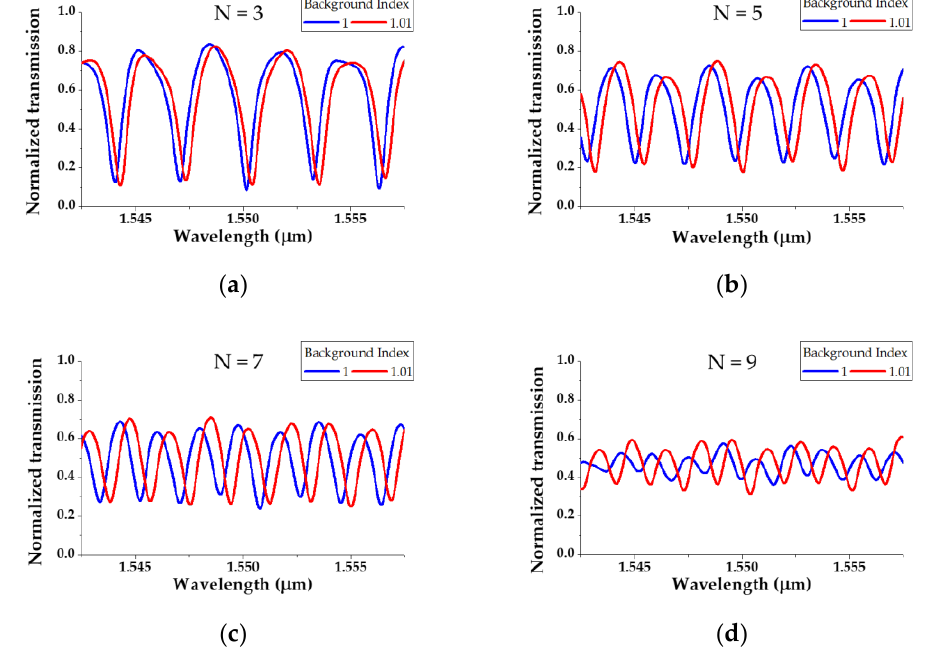
Figure 5. Normalized transmission of S-bend resonator with N = 1.